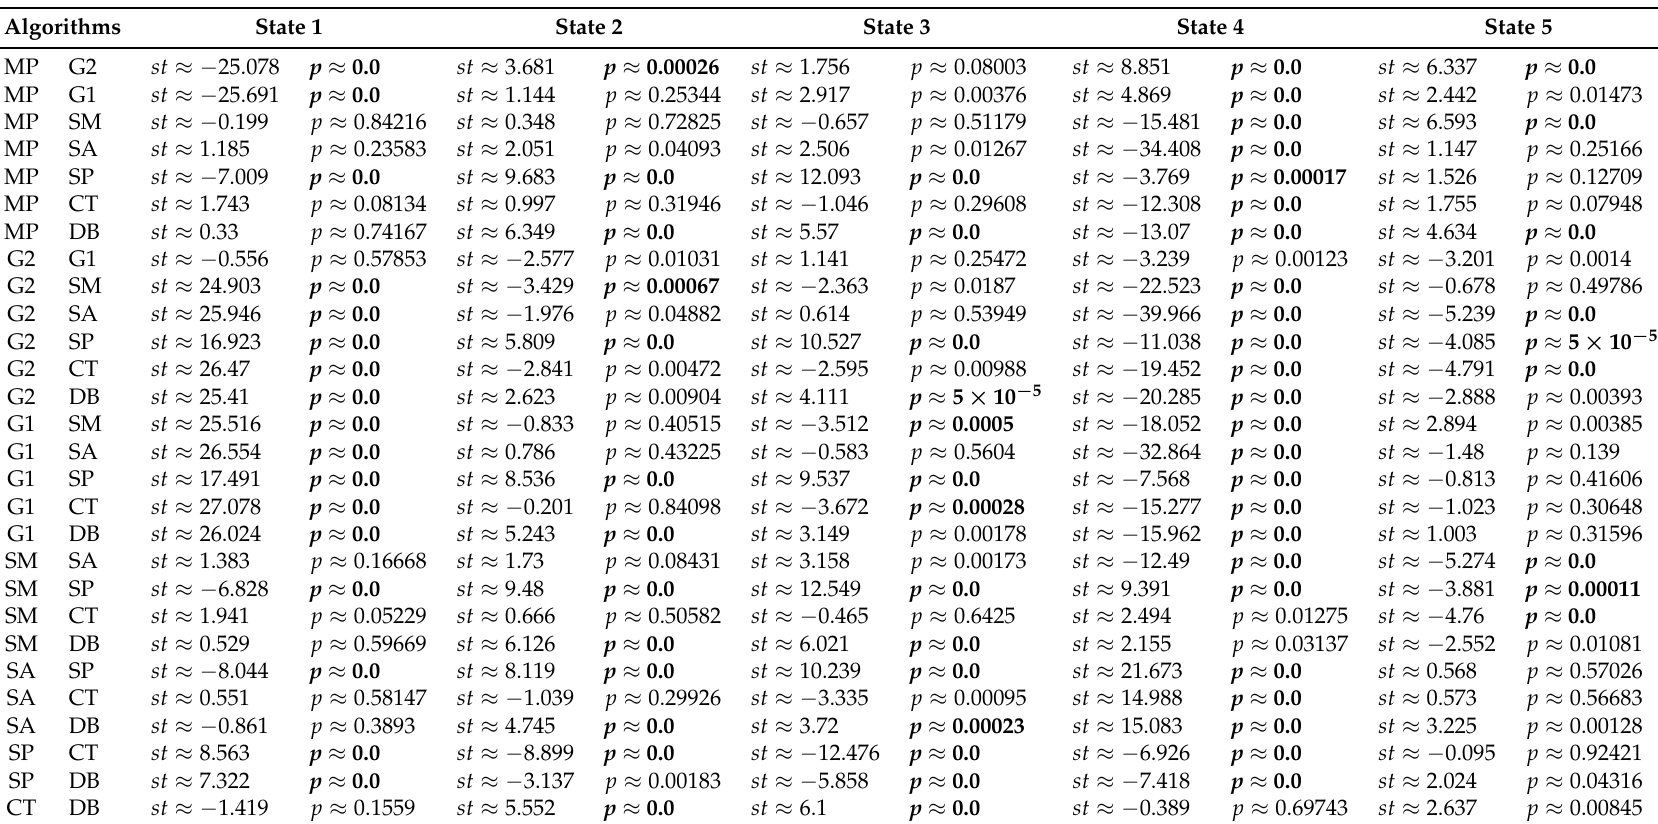
Table 8. Independent t -test applied to the data obtained from Environment 2. The Bonferroni correction was used to adjust the significance value, so that, at a confidence level of 95%, two strategies are significantly different if their p value is lower than 0.00089. The p values of such comparisons are typeset in